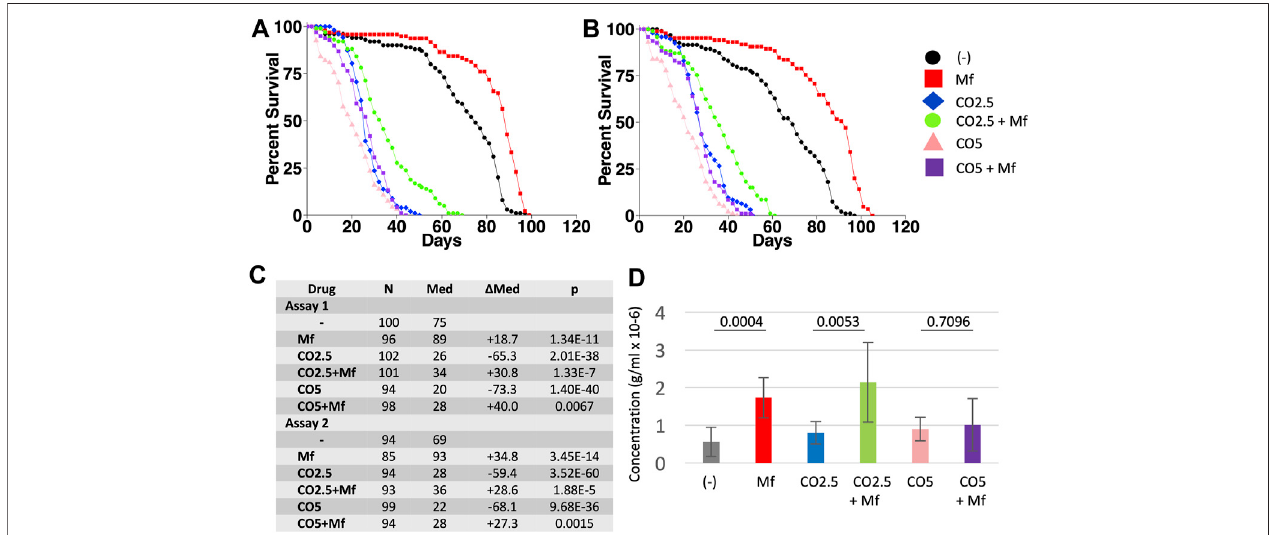
FIGURE 2 | Effect of mifepristone on life span of virgin females on control and high-fat diets. Virgin females were assayed for life span on control media, media supplemented with 2.5% coconut oil (CO2.5), and media supplemented with 5% coconut oil (CO5), in the absence ( − ) and presence (Mf) of 200 μ g/ml mifepristone. (A) Assay 1. (B) Assay 2. (C) Statistical summary for assays 1 and 2, including median life span and log-rank test results. Control media is compared to CO2.5 and to CO5. For each media type, ( − ) drug is compared to mifepristone-treated (Mf). The p value for signi fi cance with fi ve comparisons is 0.01. COX proportional hazards analyses are presented in Supplementary Table S1 . (D) Food intake determined using EX-Q assay. Data is combined for assays 1 and 2, and is presented as mean ± SD of eight replicates of 10 fl ies each. For each media type, ( − ) drug is compared to mifepristone-treated group (Mf) using unpaired, two-sided t test, and p values are presented above the bars. The p value for signi fi cance with one comparison is 0.05. Data for the individual assays is presented in Supplementary Figure S1 , and ANOVA analyses for the individual and combined assays is presented in Supplementary Table S2